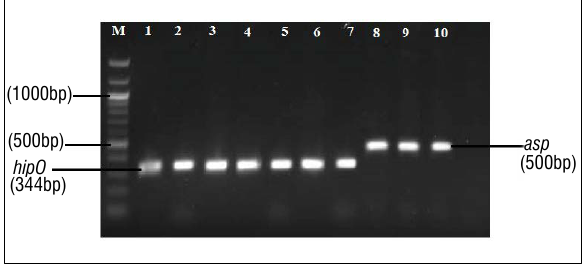
Figure 3: Agarose gel of the cdtA, cdtB, cdtC and cadF gene fragments. Genotyping of Campylobacter